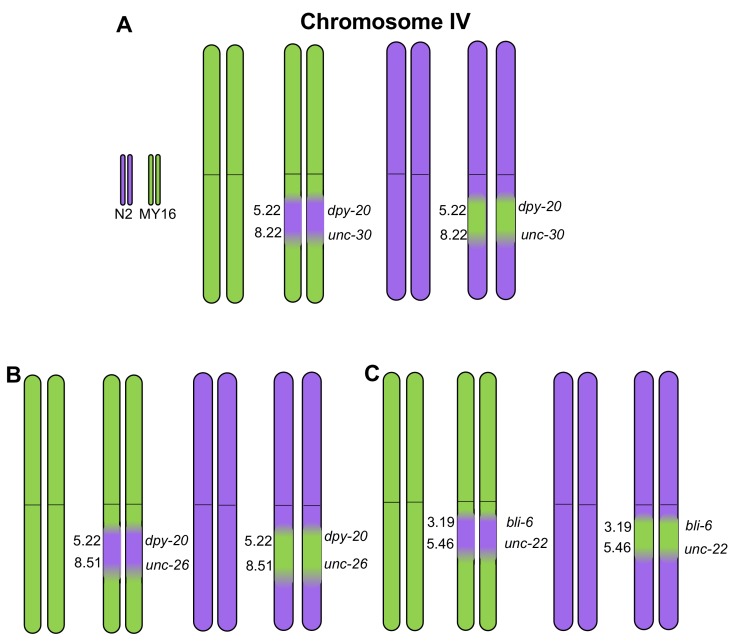
Introgression of N2 and MY16 regions in chromosome IV.Near-Isogenic Lines (NILs) were built between strains N2 (purple) and MY16 (green), using visual mutations as markers, with their locations in cM indicated in each graph. (A) Introgression of chromosome IV region flanked by dpy-20 and unc-30. (B) Introgression of chromosome IV region flanked by dpy-20 and unc-26. (C) Introgression of chromosome IV region flanked by bli-6 and unc-22.